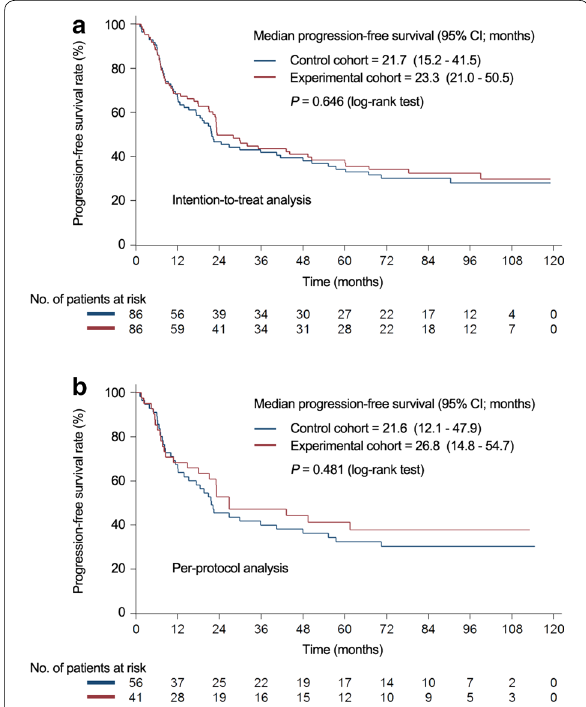
Fig. 2 Comparison of progression‑free survival rates by intention‑to‑ treat ( a ) or per‑protocol ( b ) analyses. CI confidence interval